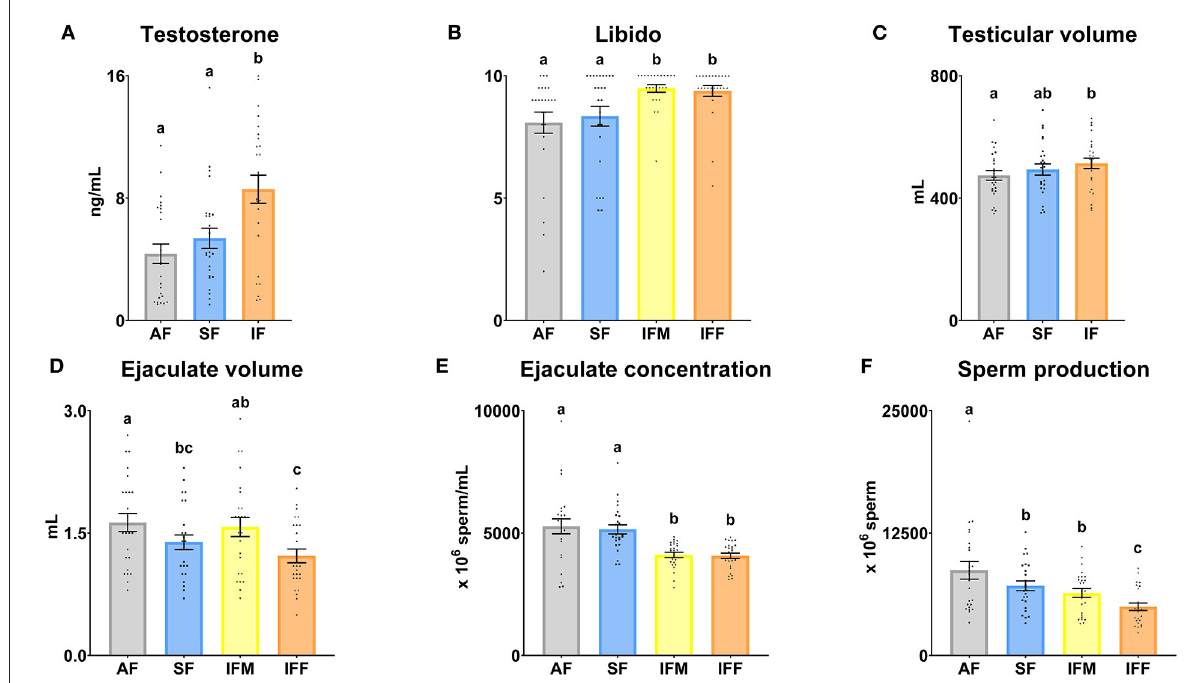
FIGURE2 Ram reproductive values according to semen collection frequencies. (A) Testosterone, serum testosterone levels (ng/ml); (B) Libido, subjective evaluation (zero to 10); (C) Testicular volume (ml); (D) Ejaculate volume (ml); (E) Ejaculate concentration ( × 10 6 sperm/ml); (F) Sperm production ( × 10 6 sperm). The same 25 males were analyzed in each experimental group (AF, abstinence semen collection frequency; SF, standard semen collection frequency; IFM, intensive semen collection frequency on Monday; and IFF, intensive semen collection frequency on Friday). Graph dots represent individual male values [graphs (A–C) ] and ejaculates [graphs (D–F) ]. Means ( ± SEM) are shown. Different lowercase superscripts letters (a–c) indicate differences ( P ≤ 0.05) among the semen collection